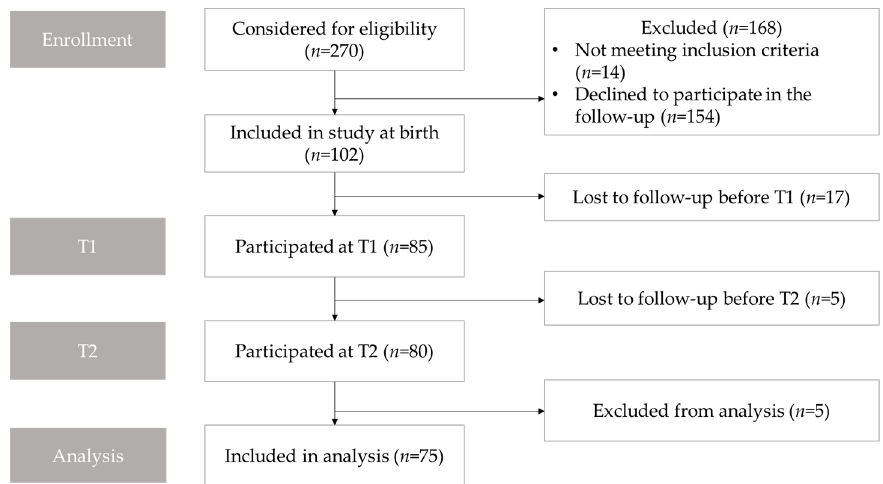
Figure 1. Flowchart showing participant enrollment, follow-up, and analysis. T1, the first follow-up approximately at the age of 12 months old; T2, the second follow-up approximately at the age of 3 years